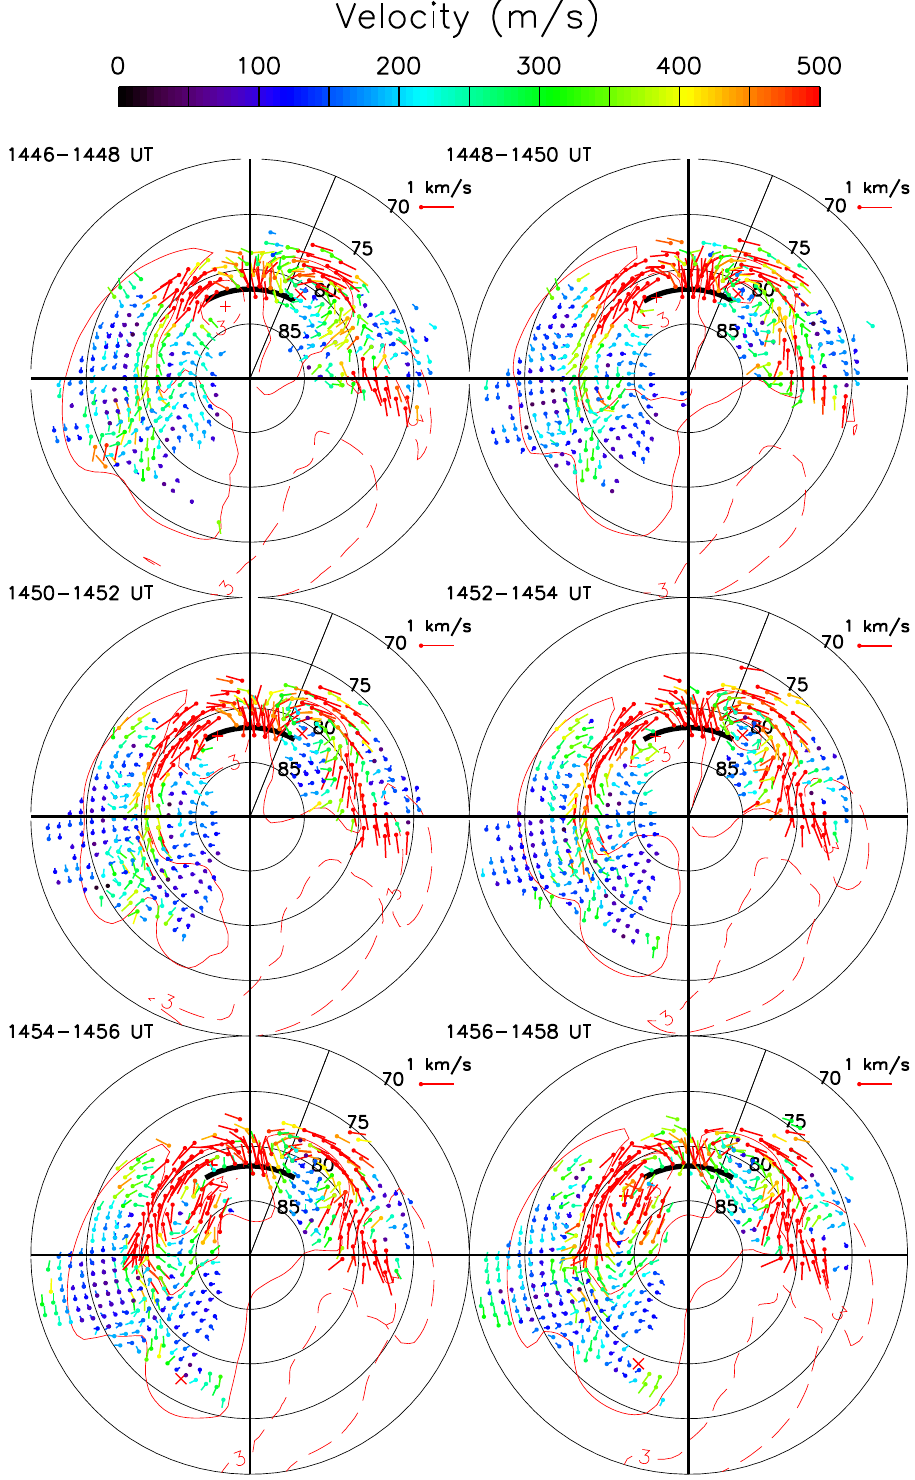
Fig. 8. Six 2-minute global convection maps in the Northern Hemisphere ionosphere covering the interval 14:46–14:58 UT on 11 November 1998. Local magnetic noon (midnight) is at the top (bottom) of each panel and dawn (dusk) is to the right (left). Each map shows the “true” vectors determined by the SuperDARN global convection mapping, colour-coded by their magnitude. The red curves represent equipotentials of the convection electric field with the red crosses denoting the centres of the reverse convection cells. The bold black arc represents the latitude of our estimate of the ionospheric projection of the merging